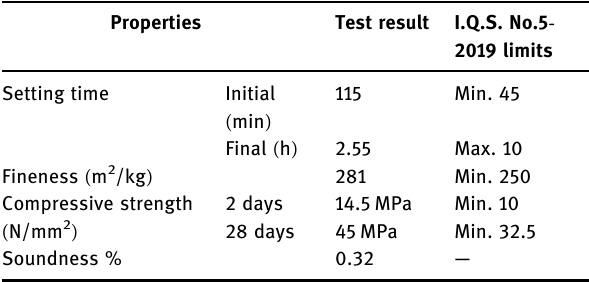
Table 1: Physical properties of the cement Properties